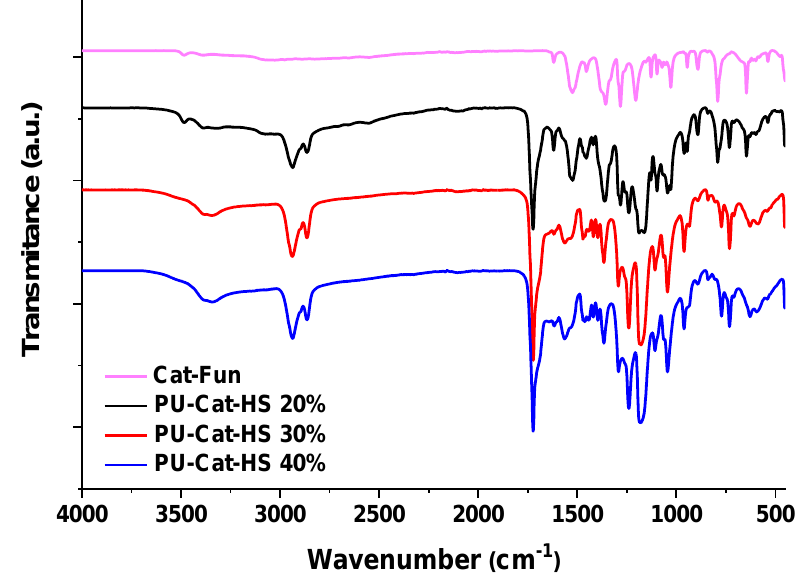
Figure 2. Attenuated total reflection Fourier transform infrared (ATR-FTIR) spectra of Figure 3. the 1 H-NMR spectrum of polyurethane PU-Cat-HS 20 bearing Cat-Fun within the hard segment is depicted.